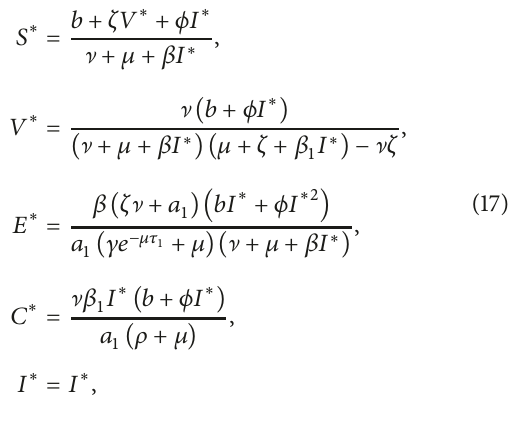
= 0.7873 , 𝑅 𝑢 = 0.1382 , 0 0